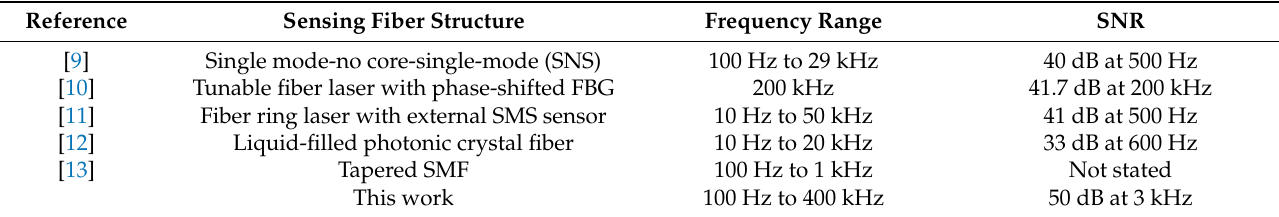
Table 1. Comparison of fiber vibration sensors in literature with proposed fiber